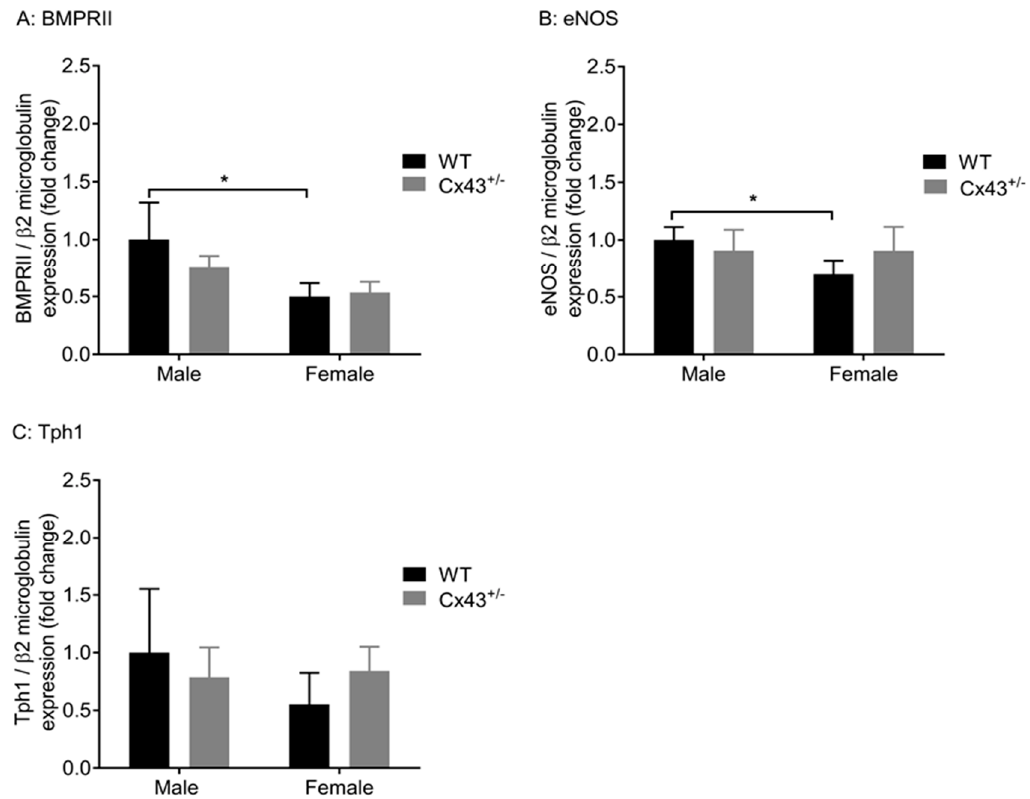
Figure 5. Gene expression of BMPRII (encoded by BMPR2 ) ( A ), eNOS (encoded by NOS3 ) ( B ), and Tph1 ( C ) in pulmonary arteries of male and female WT and Cx43 +/ − mice. No differences were observed in expression of BMPR2 , NOS3 , or Tph1 between WT and Cx43 +/ − mice (either male or female). BMPR2 and NOS3 were significantly downregulated in female WT mice compared to male WTs. Data are presented as mean ± S.E.M. and were analysed by using two-way ANOVA. * p < 0.05, n = 6 per group with each sample run in triplicate.